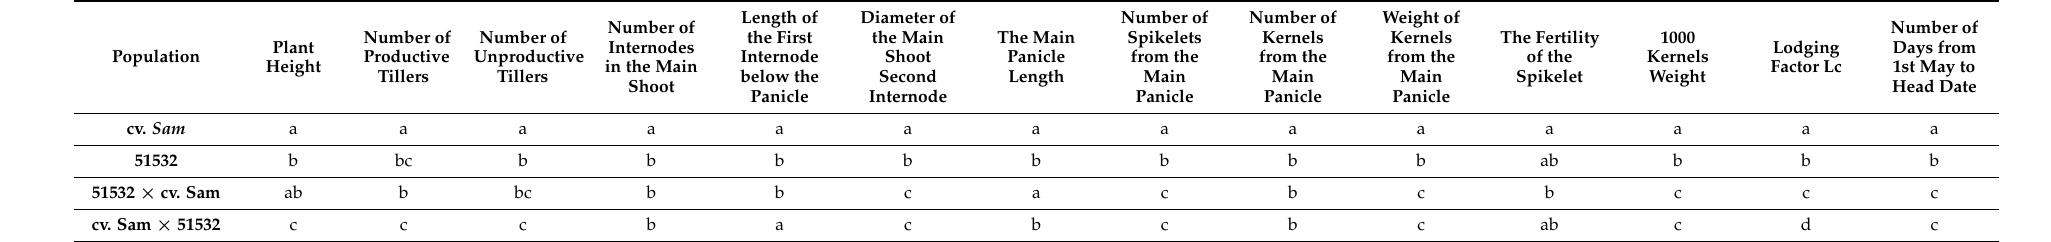
Table 2. Mean ranks post hoc comparison of agronomic traits among parental forms Avena sativa cv. Sam and Avena fatua ‘51532’ as well as their F 2 populations. Lowercase letters (a, b, c, d) indicate homogeneous groups ( p <